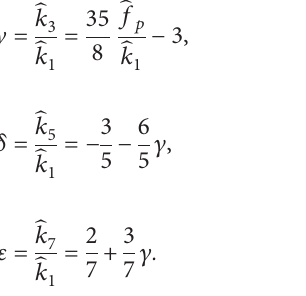
Figure 4: Relation between the aspect ratio 􏽢 b and the displacement 􏽢 z at the inflection point in case of a force-deflection curve exhibiting QZS